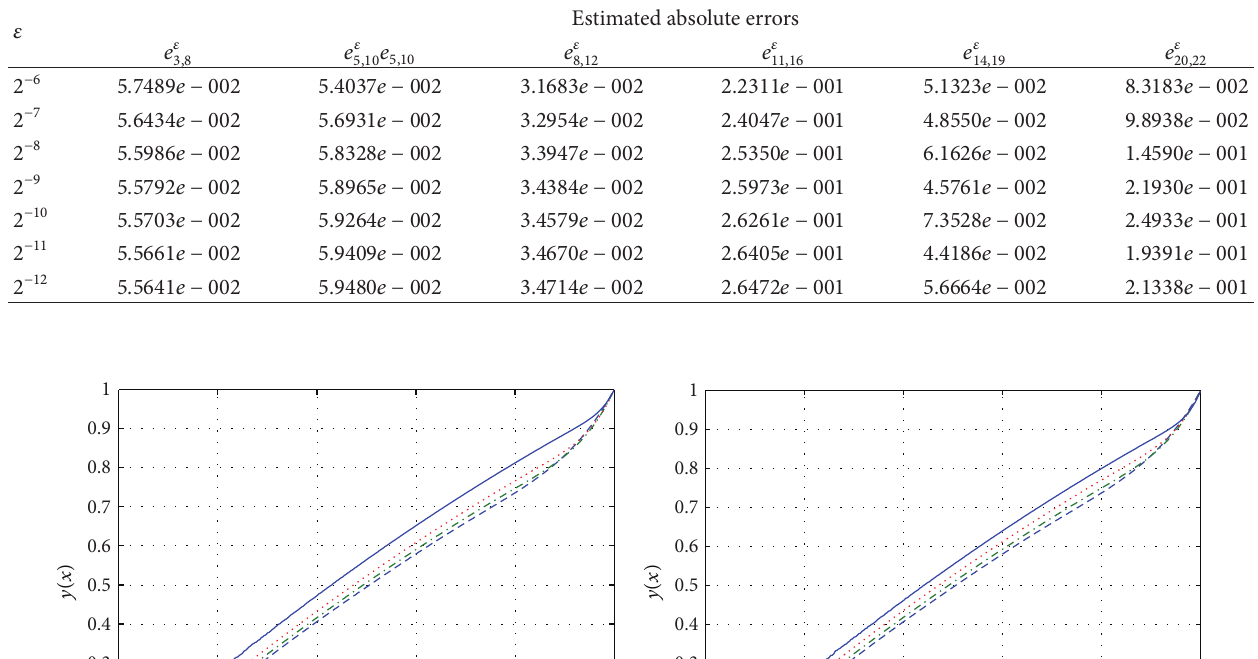
Table 1: Estimated maximum absolute errors for various values of 𝜀 = 2𝛿 , 𝑁 , and 𝑀 of (38).